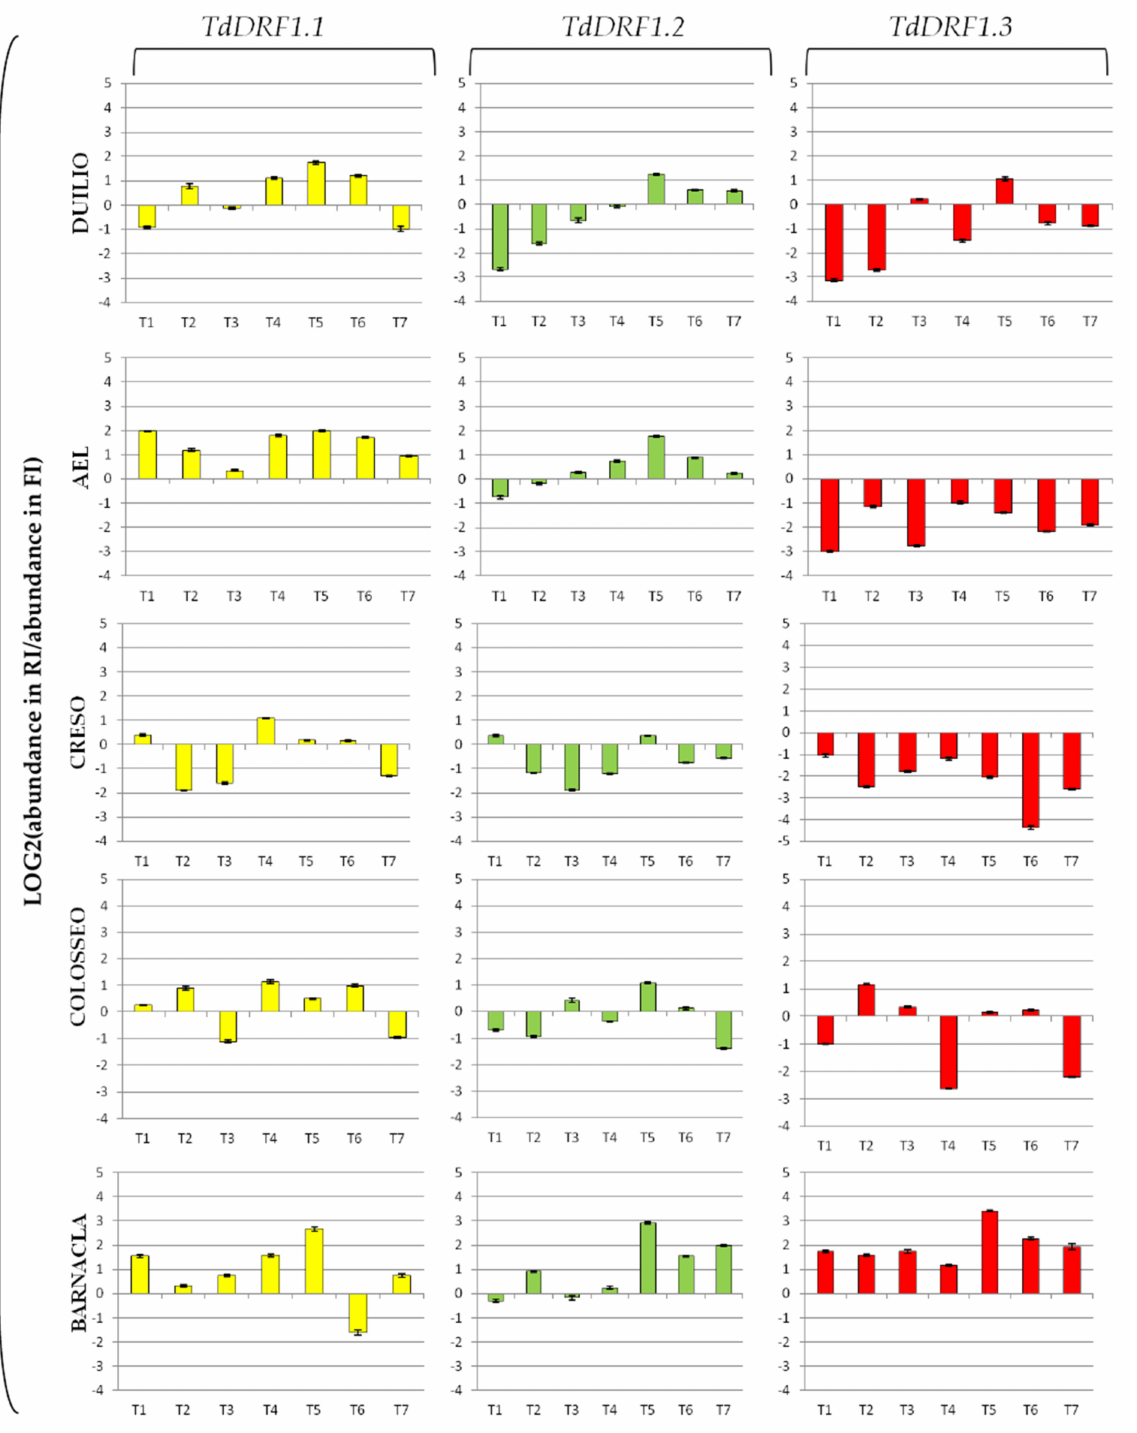
Figure 2. Expression profiles of the three TdDRF1 transcripts. Each expression profile is shown as fold change (log2 value of the ratio for abundance under stress and abundance under control). Results referred to five durum wheat genotypes analysed under both FI and RI conditions ( TdDRF1.1 in yellow, TdDRF1.2 in green, and TdDRF1.3 in red, respectively). The time course consisted of seven points (T1 to T7). Data are represented as mean ±